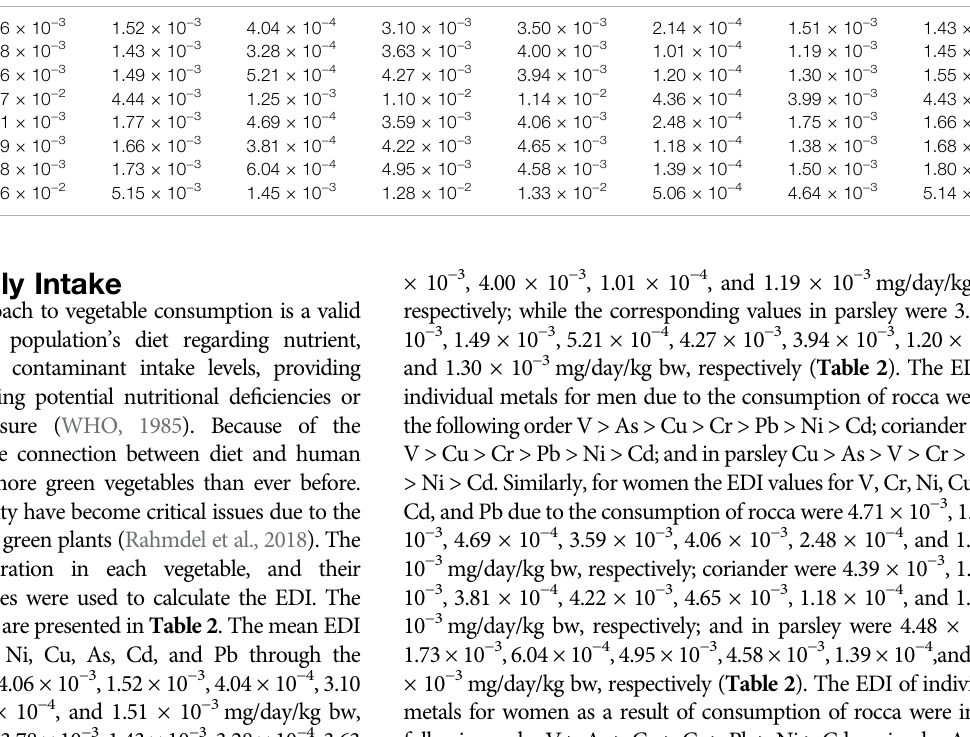
TABLE 2 | Estimated daily intake (mg/day/kg bw) of metal(oid)s for men and women due to the consumption of contaminated vegetables. V Cr Ni Cu As Cd Pb Total Men